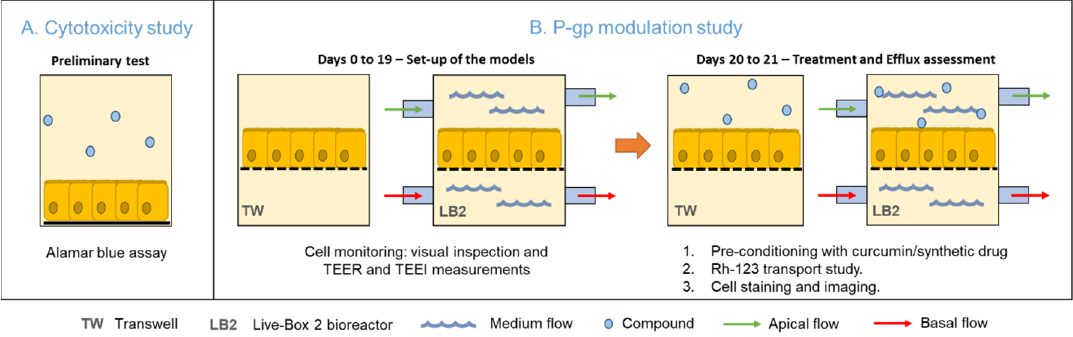
Figure 2. Representation of the experimental approach. ( A ) Preliminary study on the cytotoxicity of curcumin. ( B ) Set up of the static and dynamic in vitro models and P-gp activity assessment at the end of the 21-day culture period.